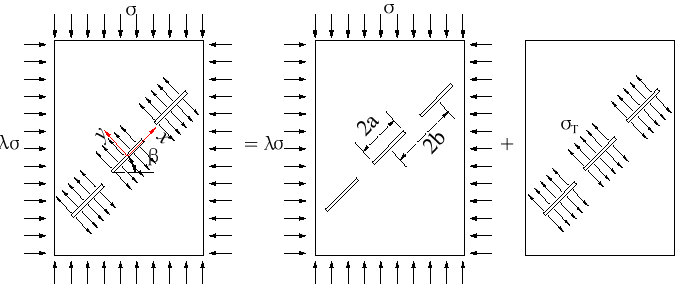
Figure 1. Freeze–thaw cracking process of fractured rock mass.